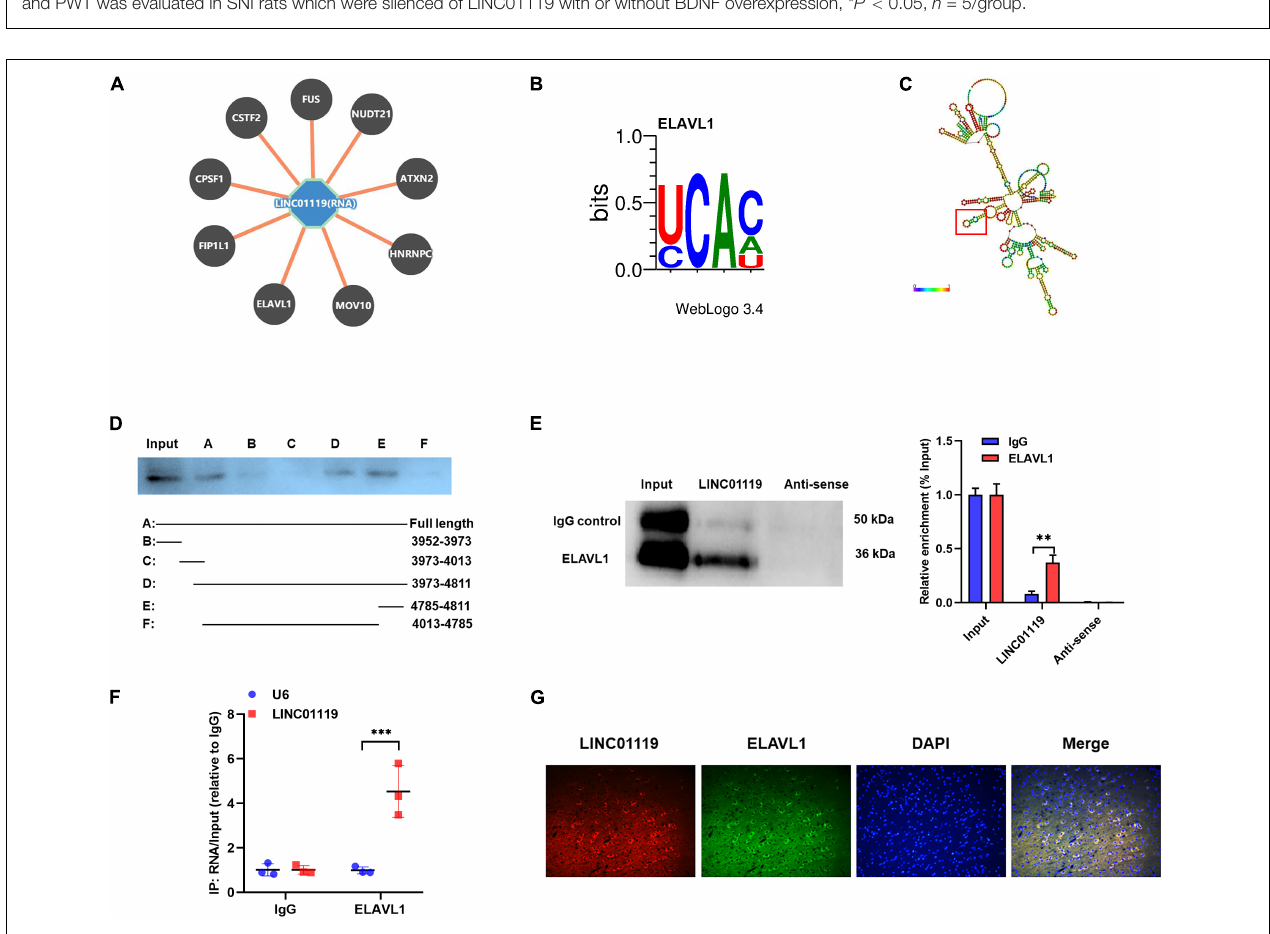
FIGURE 4 | LINC01119 directly interacts with ELAVL1. (A) The potential binding proteins of LINC01119 predicted by POSTAR (http://lulab.life.tsinghua.edu.cn/postar/index.php). (B) Predicted motif sequence of ELAVL1 was shown according to POSTAR. (C) The region of chr2:46834785-46834811 formed a stem-loop structure as predicted according to RNAfold (http://rna.tbi.univie.ac.at//cgi-bin/RNAWebSuite/RNAfold.cgi?). (D) Serial deletion analysis revealed that the chr2:46834785-46834811 region of LINC01119 was essential for binding with ELAVL1. (E) RNA pulldown assay using biotinylated LINC01119 and antisense control were performed using spinal cord of SNI rats, ** P < 0.01, n = 3/group. (F) RIP assay with ELAVL1 antibody further confirmed the direct interaction between LINC01119 and ELAVL1 in SNI rats, *** P < 0.001, n = 3/group. (G) RNA-FISH with specific probe using SNI rats verified that LINC01119 and ELAVL1 protein colocalized mostly in the cytoplasm section ( n = 3/group). Scare bar = 100 µ